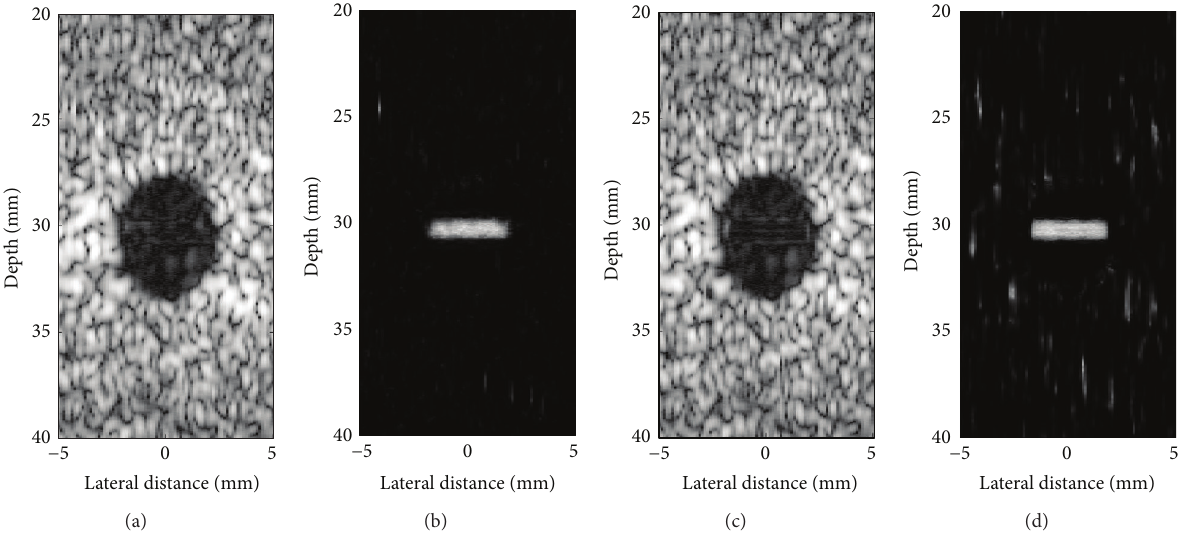
Figure 6: Visual comparison of clutter reduction on IQ data of simulation images obtained by (a) MCA and (c) SVF. The absolute difference between (b) the perfect filtered signal and the MCA reconstruction and (d) the perfect filtered signal and the SVF reconstruction.